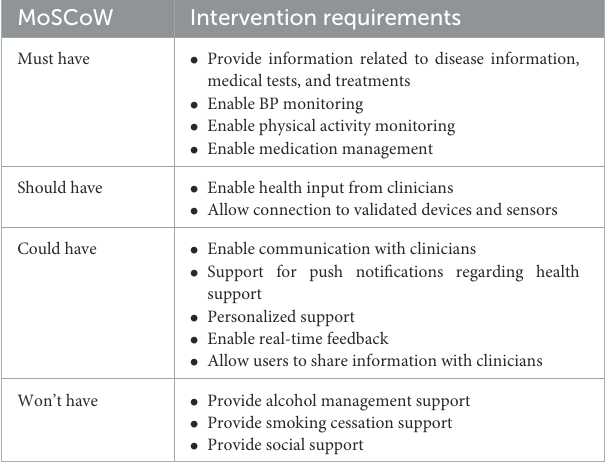
TABLE 1 Intervention requirement based on the MoSCoW prioritization model to support hypertension self-management identified through an assessment of user